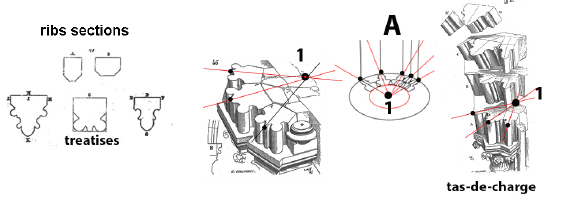
Figure 4 : Tas de charge: geometric rules from sources